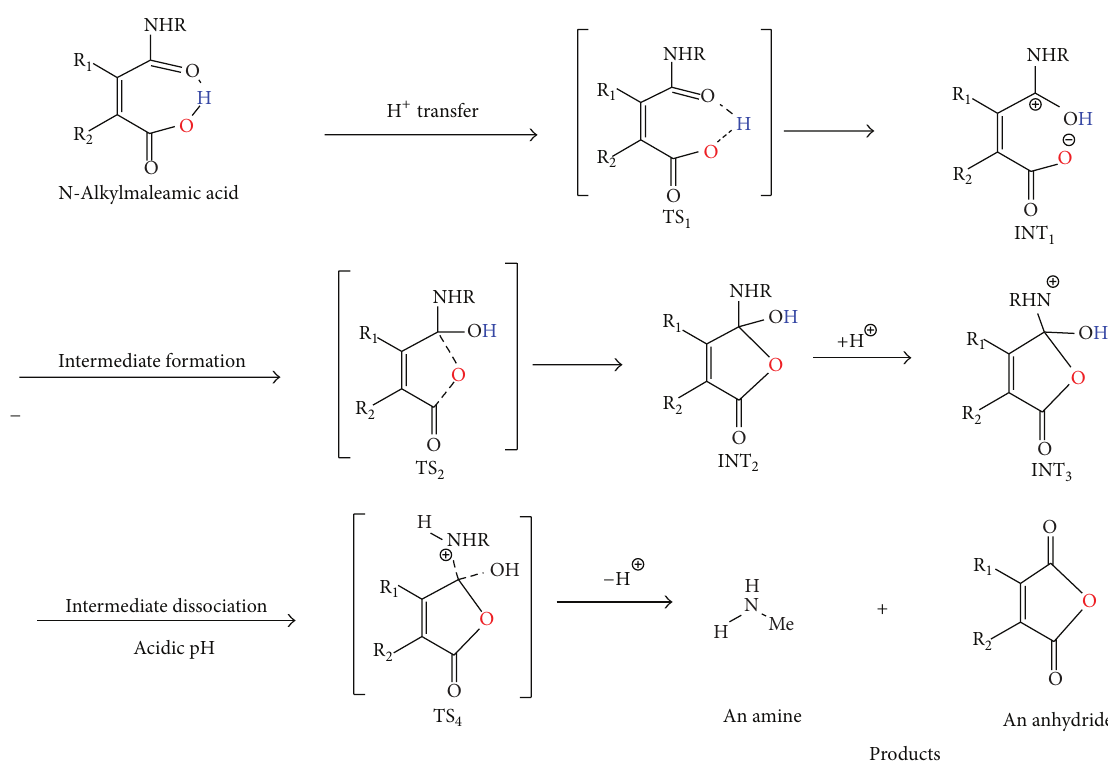
Figure 4: Mechanistic pathway for the acid-catalyzed hydrolysis of 1–9 and atenolol ProD 1-ProD 2. TS and INT are tetrahedral intermediate and transition state,